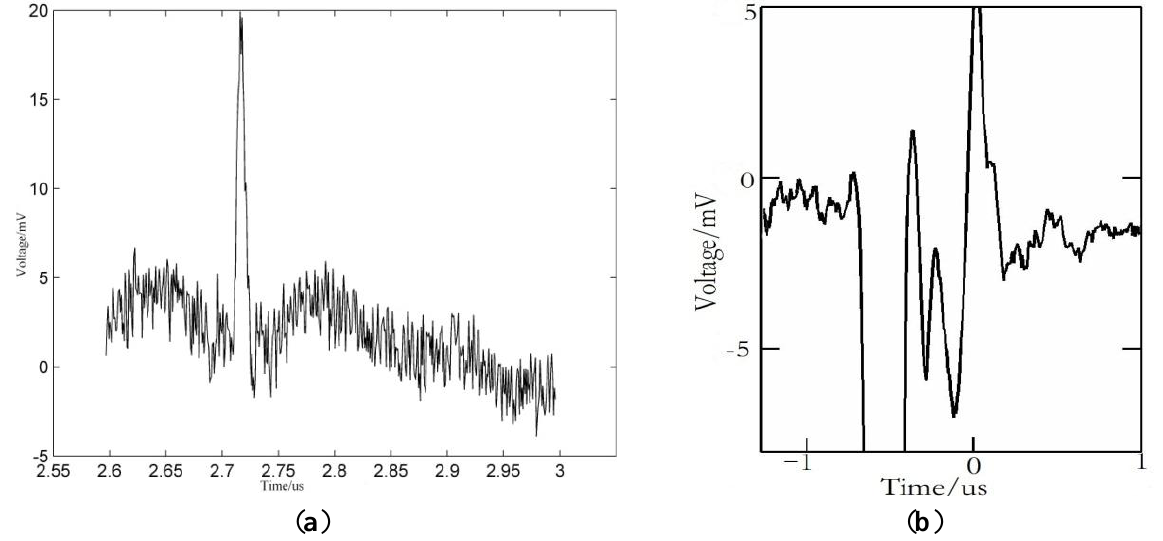
Figure 1. Time domain waveforms of the SAW signals obtained by ( a ) piezoelectric LSAW detection technique and ( b ) differential confocal LSAW detection